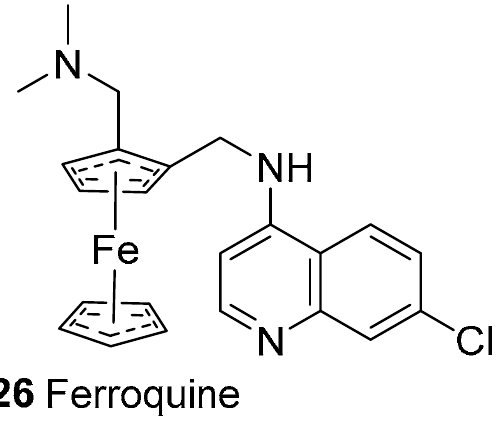
Figure 9. Ferroquine ( 26 ).